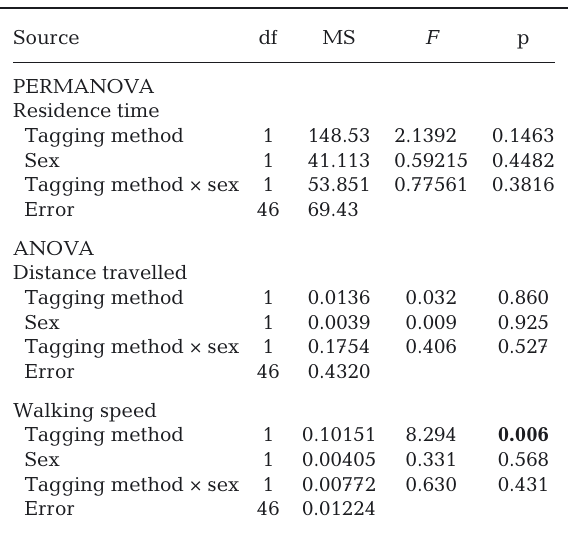
Table 2. Results of PERMANOVA and ANOVAs evaluating the influence of ‘tagging method’ (in situ and ‘on boat’) and ‘sex’ on the lobster behavior during the 24 h acclimation pe- riod in 2017. Significant effects (p < 0.05) are highlighted in bold